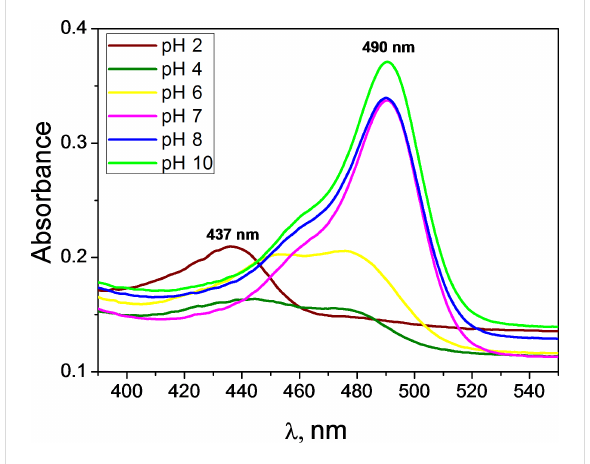
Figure 7: UV–vis spectra of a water suspension of P(AA- co -FA)-func- tionalized BNNTs (1 mg/mL) at various pH values.